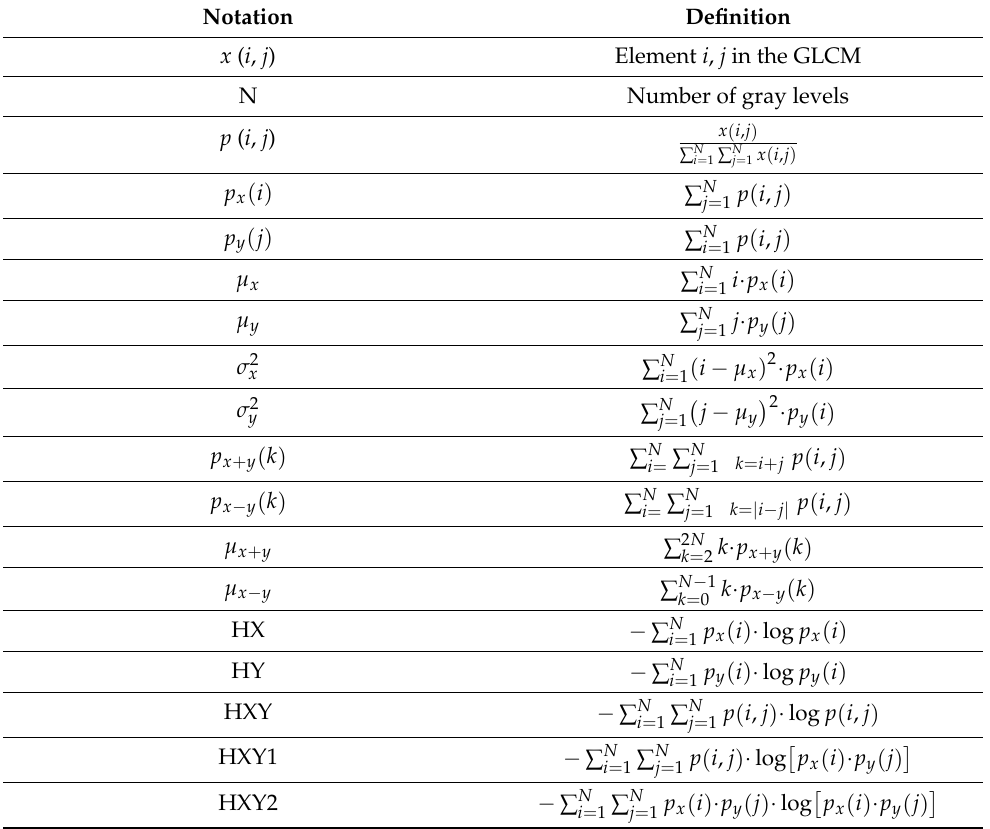
Table 2. Variables and notations used to compute the texture